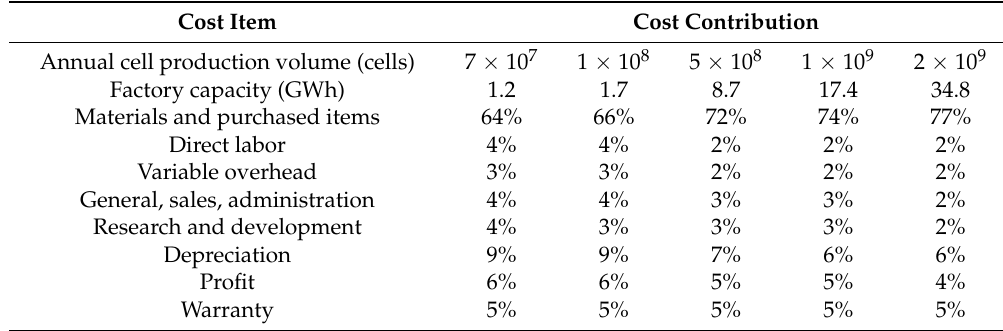
Table 3. Cost repartition of a 20-kWh lithium nickel cobalt aluminium oxide (NCA) pack manufactured in Korea with an average cathode active material